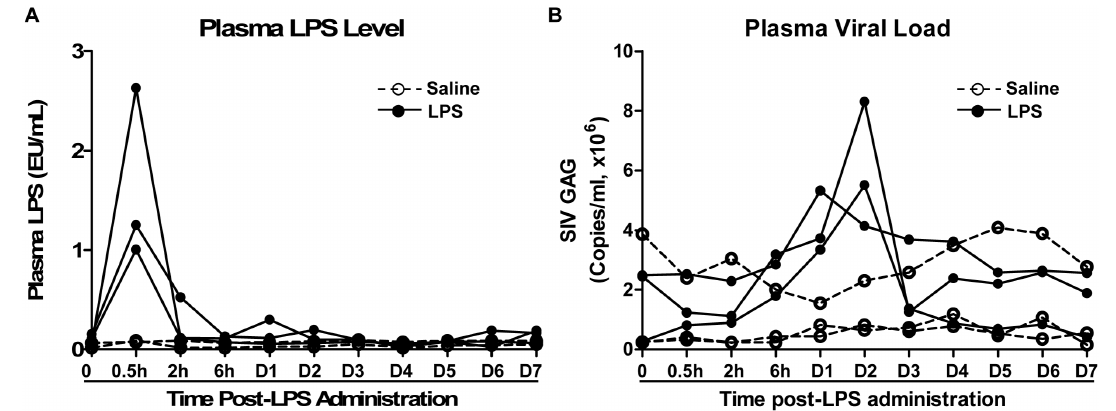
Figure 2. Effect of LPS on SIV replication. SIV-infected animals were intravenously injected with either a single dose of LPS (50 m g/kg; solid circles and lines, n=3) or saline (open circle and dashed lines, n=3) at 45 weeks postinfection. The plasma samples were collected at the indicated time points after LPS treatment. A: The plasma levels of LPS were determined by Tachypleus Amebocyte Lysate (TAL) test. B: SIV loads were measured by real-time PCR for SIV GAG gene expression.